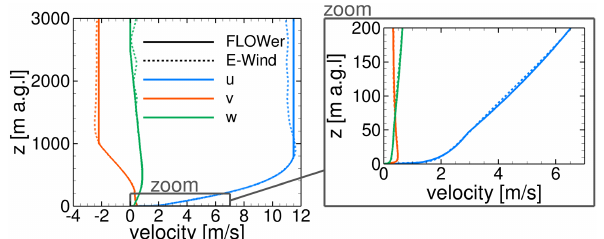
Figure 4. Mean velocity profiles at the FLOWer inlet for the en- tire height of the domain and zoomed in to near ground level, as extracted from E-Wind and approximated for FLOWer